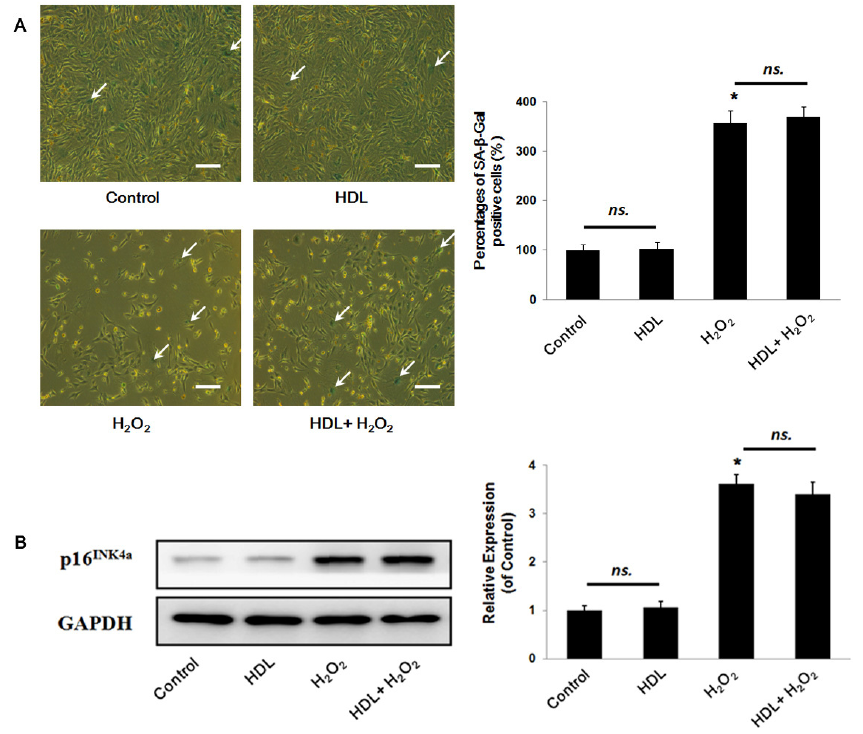
Figure 2. Influence of HDL in the MSC senescence. MSCs were treated with or without HDL for 24 h followed by exposure to H O insult for another 24 h or not; 2 2 ( A ) Senescence-associated β -Galactosidase staining and representative photograms from three independent experiments are displayed (scale bar = 20 μ m); ( B ) The expressions of p16 INK4a were detected by Western blot analysis and representative bands are shown. Data are shown as mean ± SE from three independent experiments. * p < 0.05 vs. Control